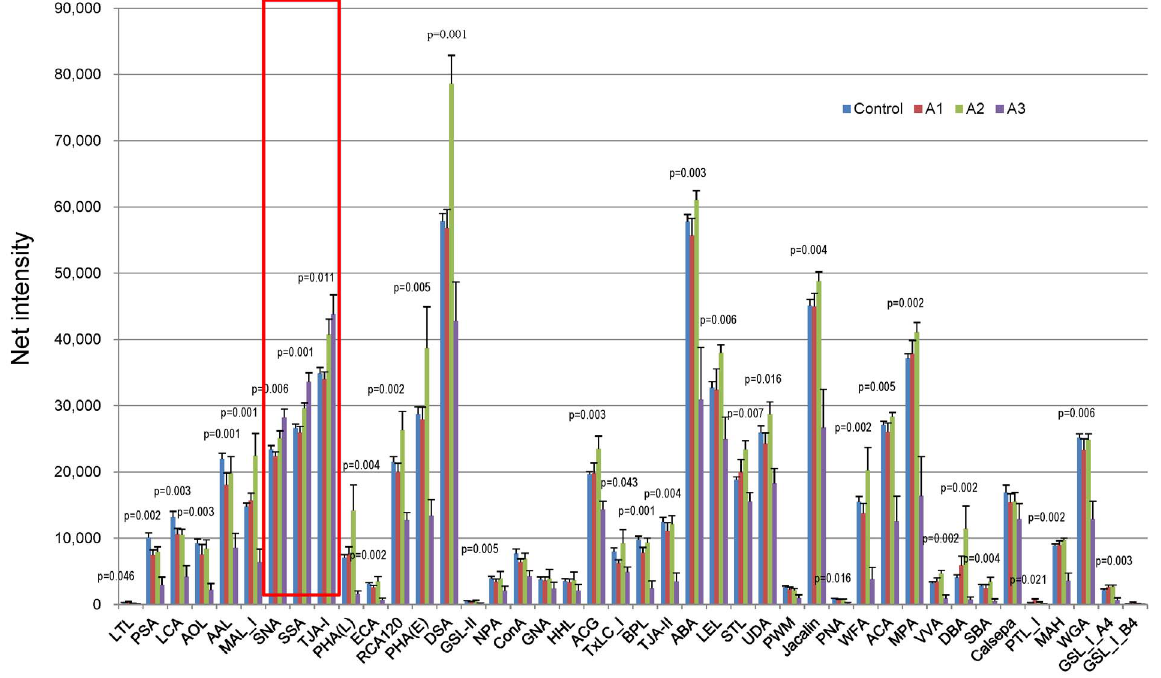
Figure 1. Lectin microarray analysis using urine samples from the patients with various albuminuria stages. Lectin microarray analysis of urine samples were performed in the healthy subjects without type 2 diabetes (Control, n=12) and the patients with type 2 diabetes with various stages of normoalubuminuria (A1, n=7), microalbuminuria (A2, n=5) and macroalbuminuria (A3, n=5). Signals to various lectins are compared by Kruskal-Wallis test.